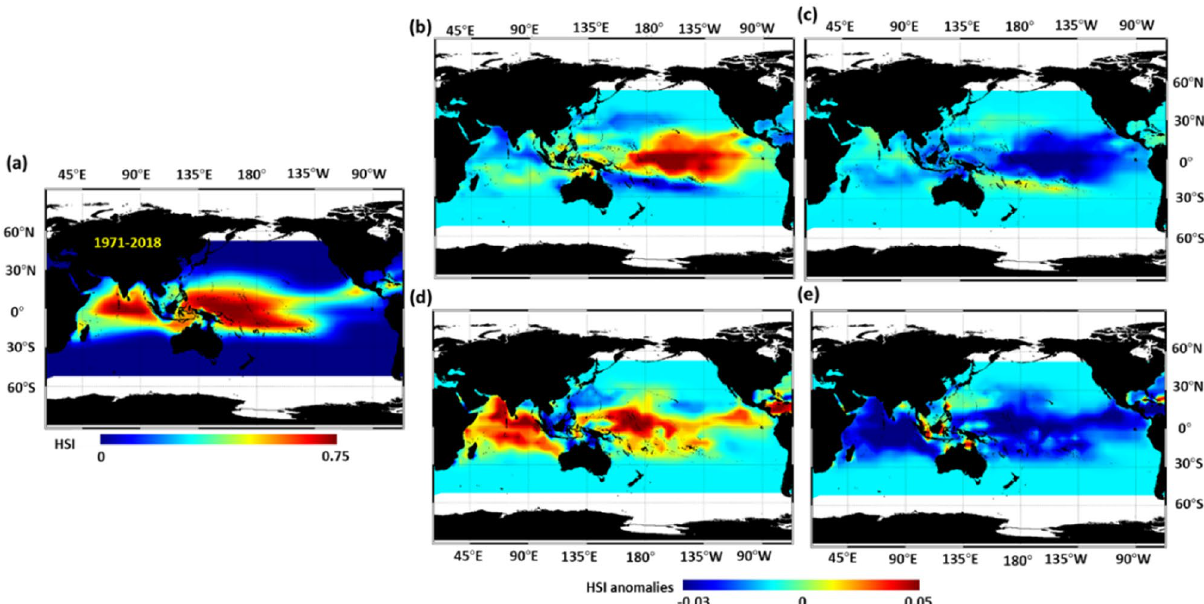
Figure 3. HSI spatial distributions anomalies. Distribution from ( a ) 1971–2018; ( b ) during positive PDO phase minus whole study period (1971–2018); ( c ) during negative PDO phase minus whole study period (1971–2018); ( d ) during positive AMO phase minus whole study period (1971–2018); ( e ) during negative AMO phase minus whole study period (1971–2018). Figure created with Interactive Data Visualization Solution (IDL v 8.7) software. Software Resource: https:// www. l3har risge ospat ial. com/ Softw are- Techn ology/ IDL.